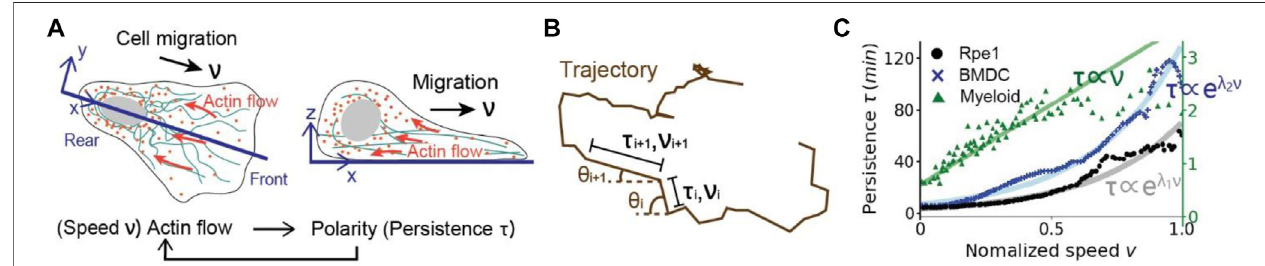
FIGURE 1 | The correlation between migratory speed v and persistence τ is a universal phenomenon existing in the cell migration. (A) , Schematics of the cell migration. The correlation between speed and persistence is caused by the intracellular actin fl ow reinforcing the cell polarity. (B) , Schematics of a cell trajectory, which consists a series of straight motions. The time duration of a straight motion i is referred to as persistence τ i , and the migration speed is v i and direction is θ i . (C) , Experimentally measured migration speed and persistence of Retinal pigment epithelial cells (Rpe1) (mesenchymal migration model) and bone marrow-derived